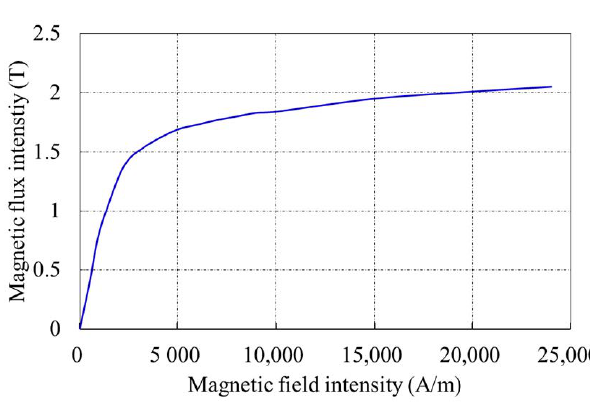
Figure 4. B-H curve of the pipe model.